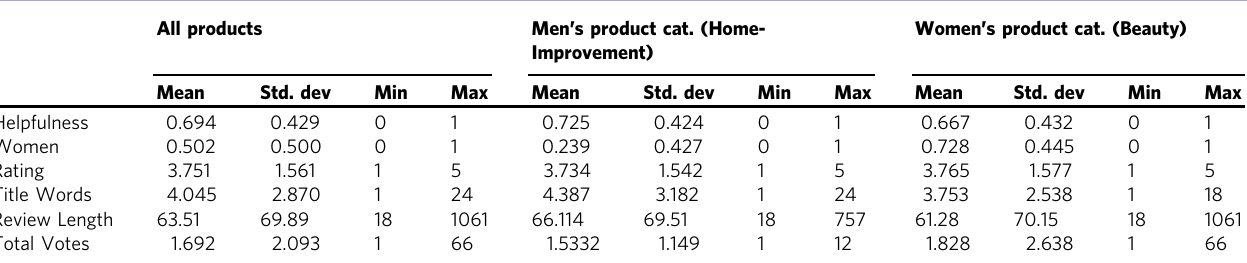
Table 5 Summary statistics of amazon data by gendered product type and full sample. All products